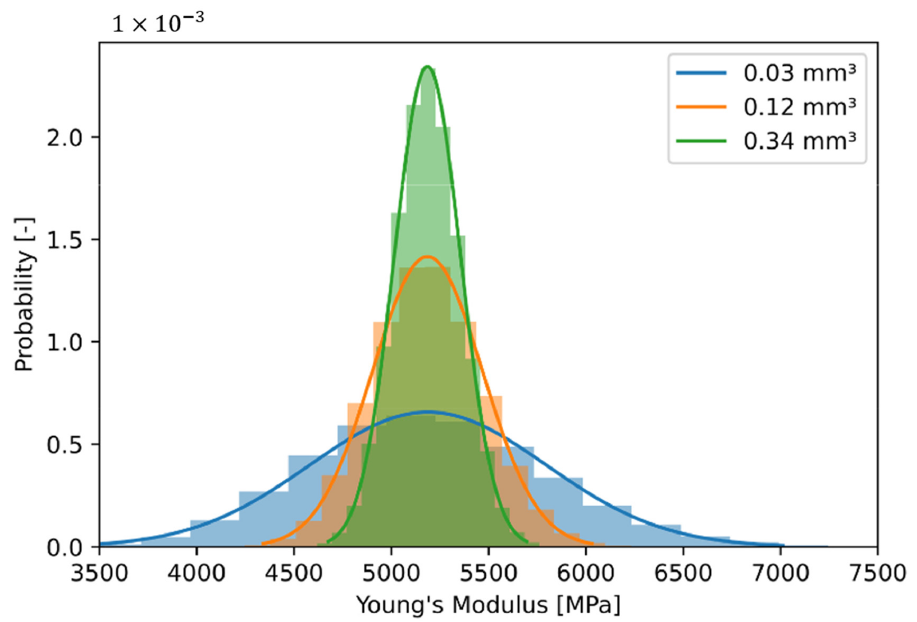
Figure 13. Histogram of drawn effective stiffness in dependency of considered volume.